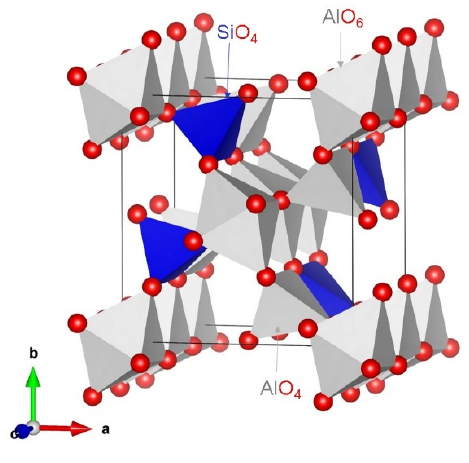
Figure 1. Crystal structure of Al 2 SiO 5. Table 1. Buckingham potential parameters [27,28] used in the classical simulations of Al 2 SiO 5 . Two-body